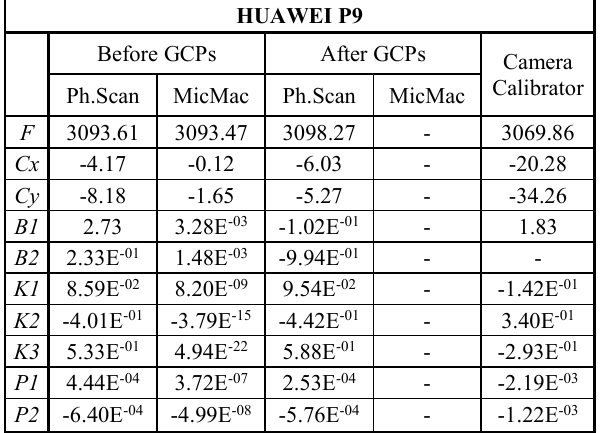
Table 11. Calibration parameters for the Huawei smartphone evaluated with self-calibration before and after placing GCPs and parameters estimated by MatLab Single Camera Calibrator